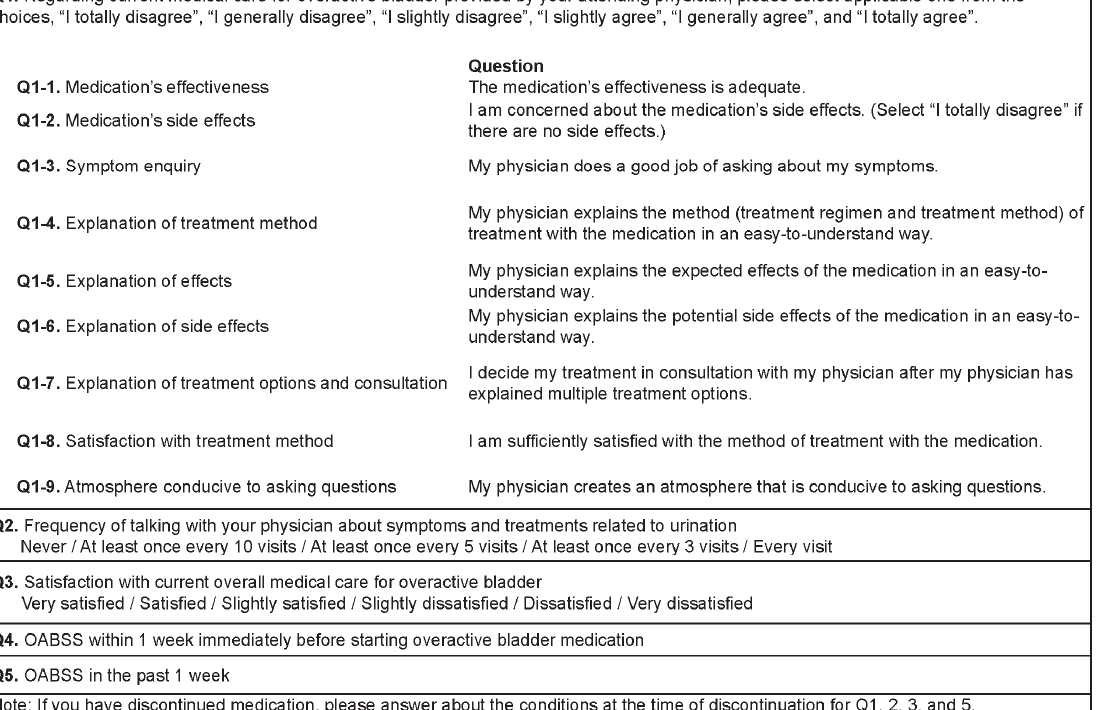
Figure 1. Survey questions. OABSS, overactive bladder symptom score.